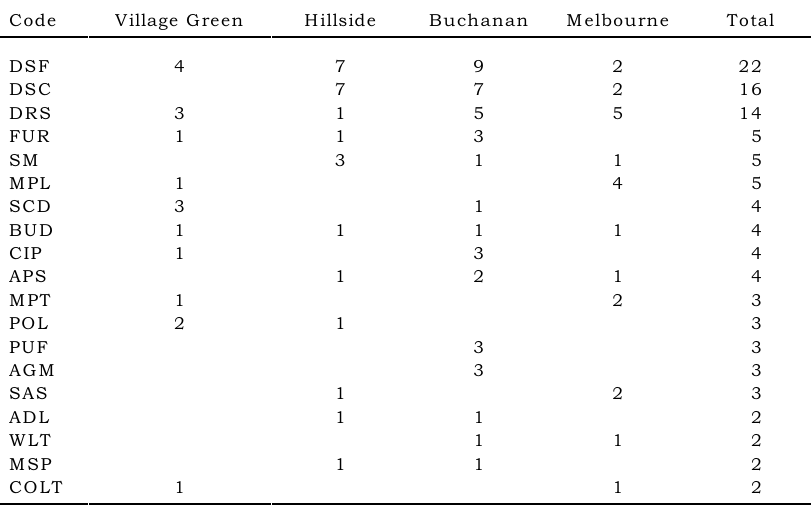
Table 2 The actual functions of parents in the school governing body